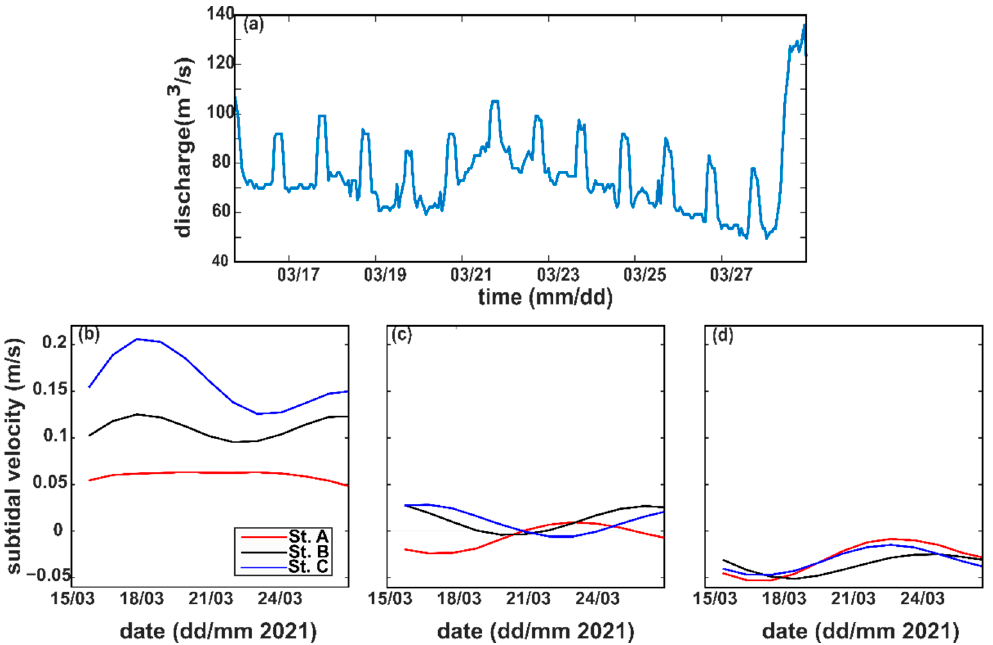
Figure 5. River discharge at the Yaguchi Gauging Station ( a ) and subtidal velocities at the upper depth, ( b ) mid-depth ( c ), and lower depth ( d ) at Stations A, B, and C.